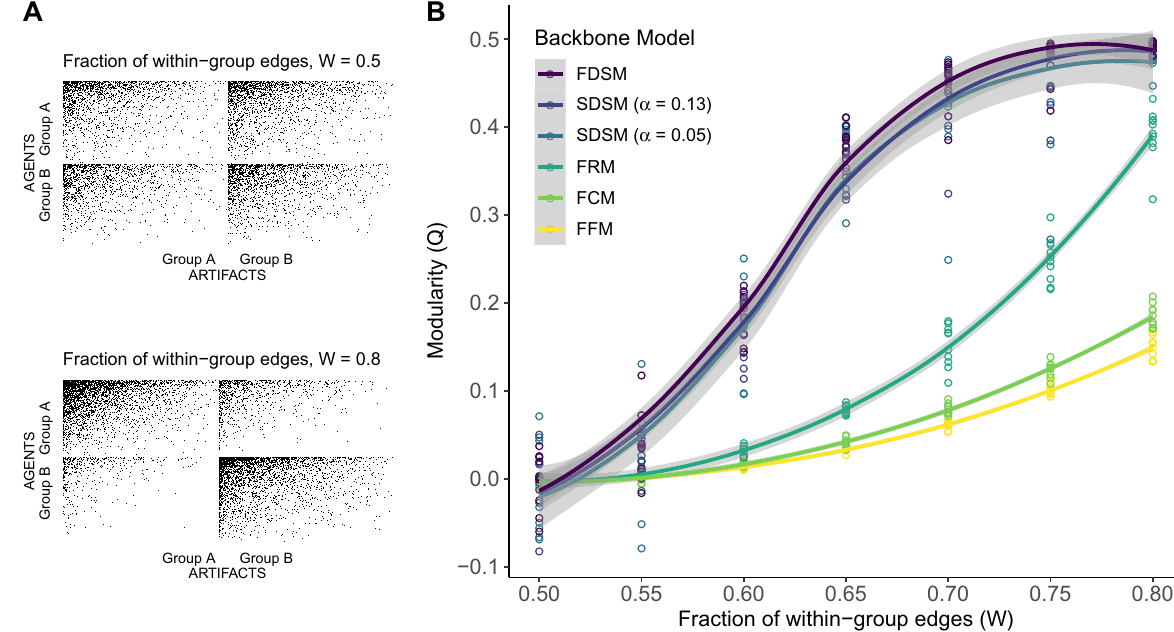
Figure 5. ( A ) Synthetic bipartite networks with varying levels of block structure, from which ( B ) backbones extracted using different models exhibit varying